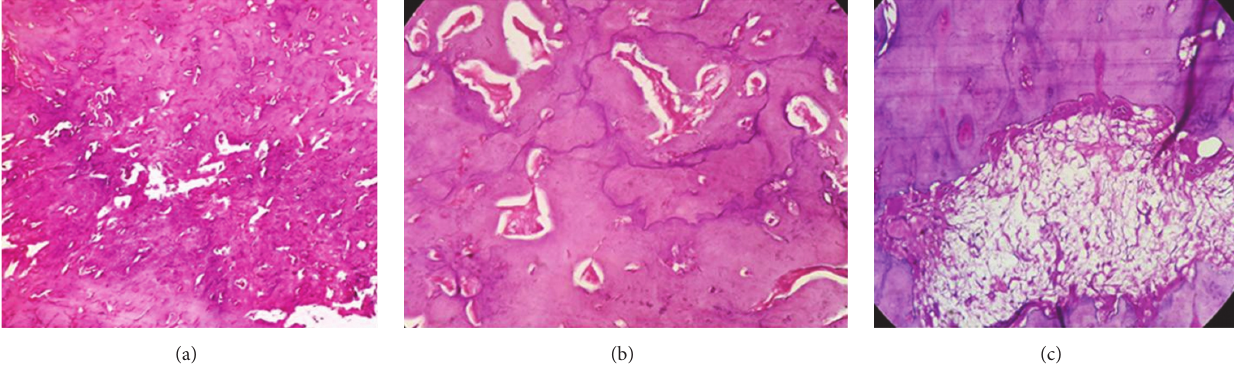
Figure 3: (a) H&E 10x view shows proliferation of cementocytes. (b) H&E 40x view shows basophilic reversal lines. (c) H&E 40x view shows multinucleated resorptive cells in connective tissue